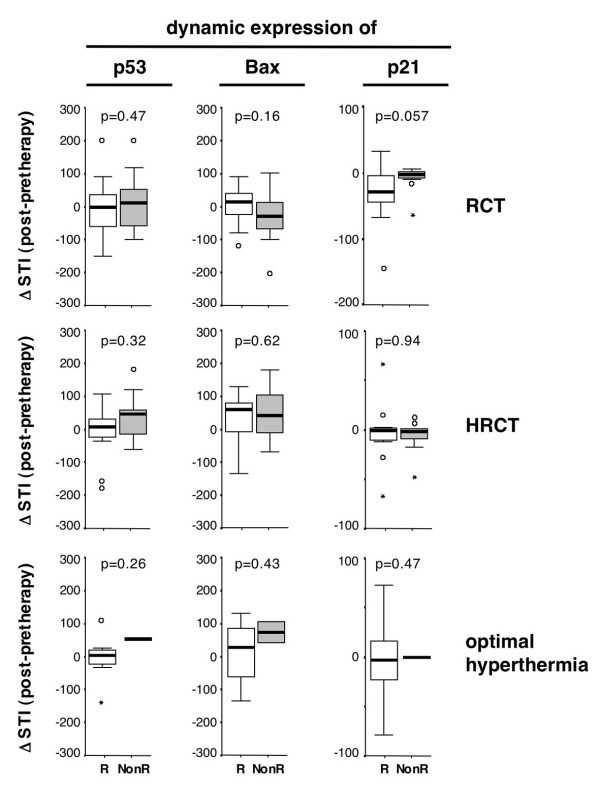
Dynamic expression of p53, Bax, p21CIP/WAF-1 and response to therapy in rectal carcinomas. Box plot analysis of staining indices for p53, Bax and p21CIP/WAF-1 (post-therapy staining index (STI) – pre-therapy STI. White bars: Responders (R), grey bars: Non-responders (NonR). RCT: responders n = 14, non-responders = 12, HRCT: responders n = 11, non-responders = 9, Optimal hyperthermia: responders n = 8, non-responders = 3.